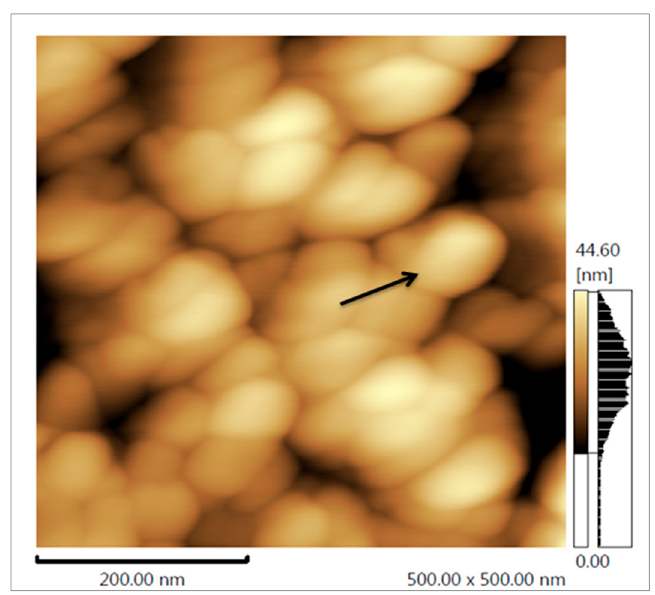
Figure 4. Atomic force microscopy (AFM) images of FN. The arrow points to one of the nanoparticles in the image.